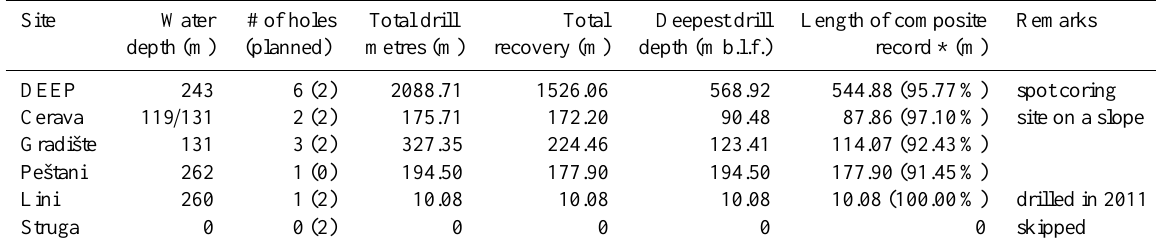
Table 1. SCOPSCO drill